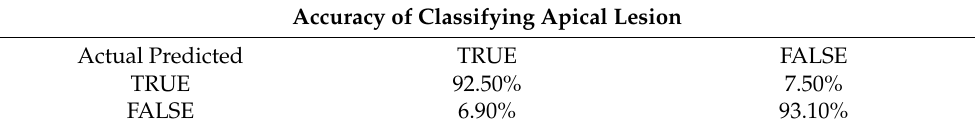
Table 9. Truth table of accuracy for classifying apical lesion.